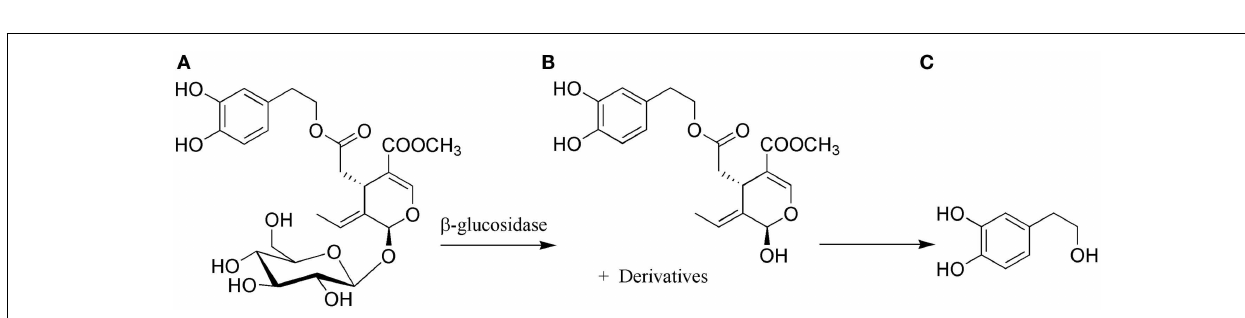
FIGURE 1 | Hydroxytyrosol and derivatives in olive and olive oil . Adapted from Boskou (10).